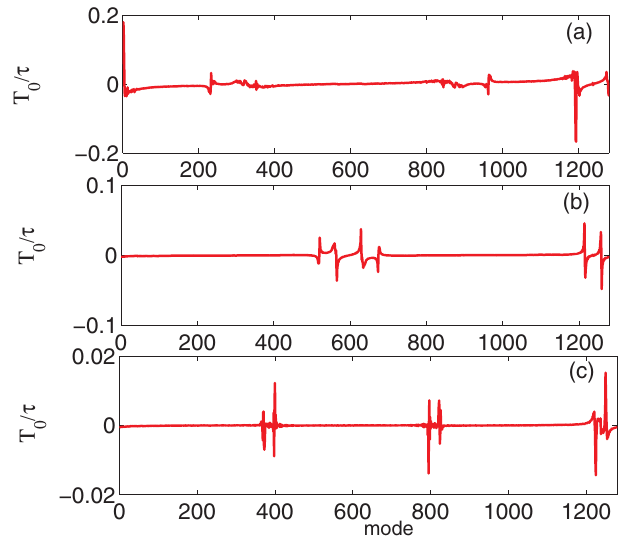
FIG. 12. (Color) Growth rate of coupled-bunch instability for (cid:1) 10 , 20, and 30 G estimated by the wake force in Figs. 10 B z and 11 for an initial displacement of 5 mm.